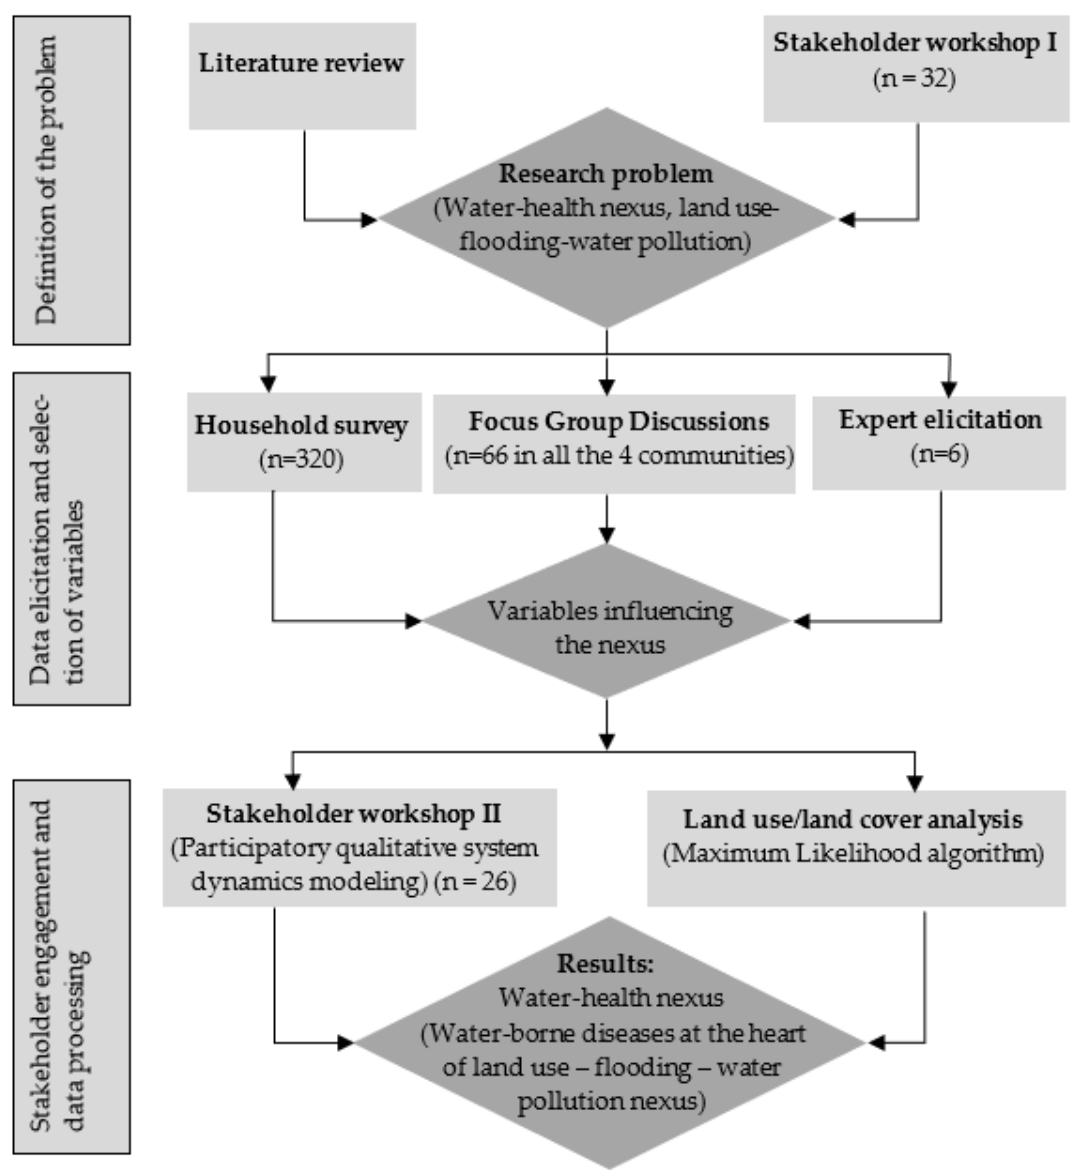
Figure 2. Flowchart showing the methodological steps. Source: Authors’ own work (2021).